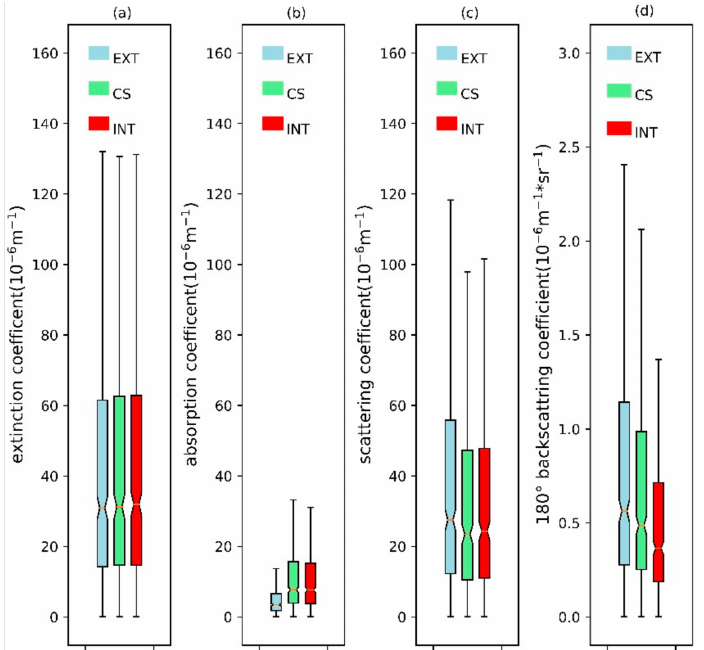
Figure 5. ( a ) Extinction coefficients, ( b ) absorption coefficients, ( c ) scattering coefficients, and ( d ) backscattering coefficients of aerosols under three mixing states.